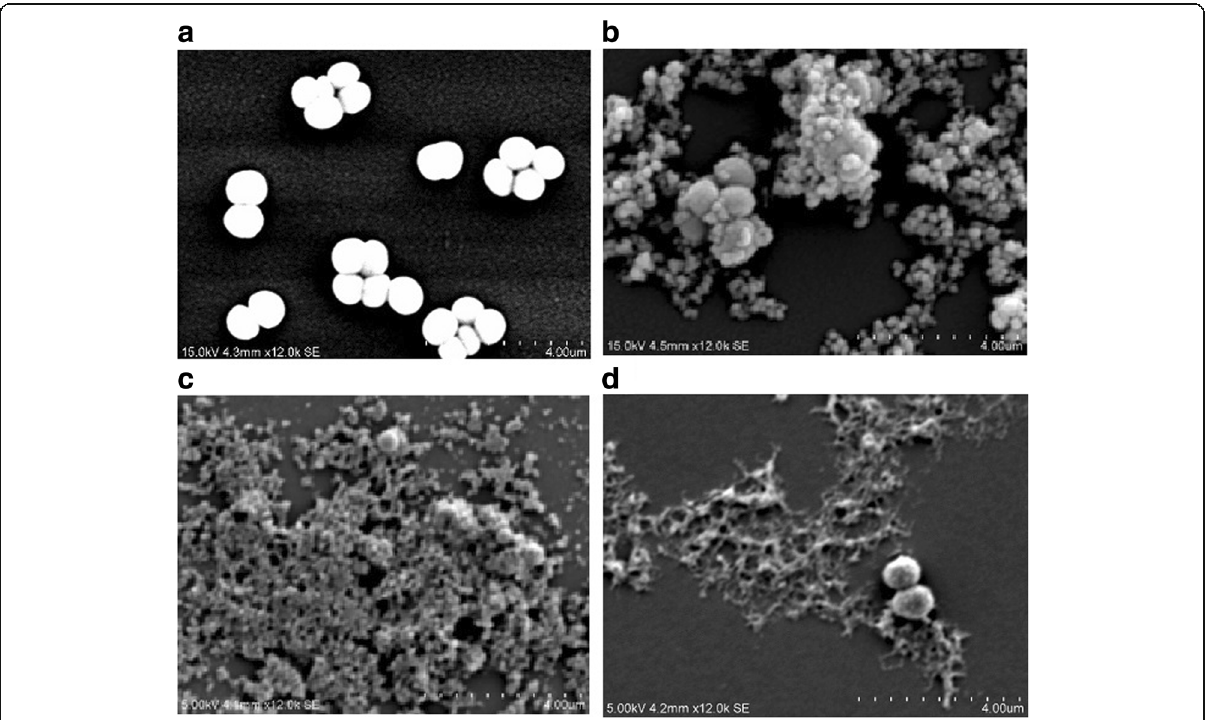
Fig. 4 Scanning electron microscopy (SEM) photograph of MRSA treated with ethyl acetate and isolated active compounds of B. kockiana flower at 2 × MIC ( a ) Control ( b ) treated with ethyl acetateextract ( c ) treated with compound 1 ( d ) treated with compound